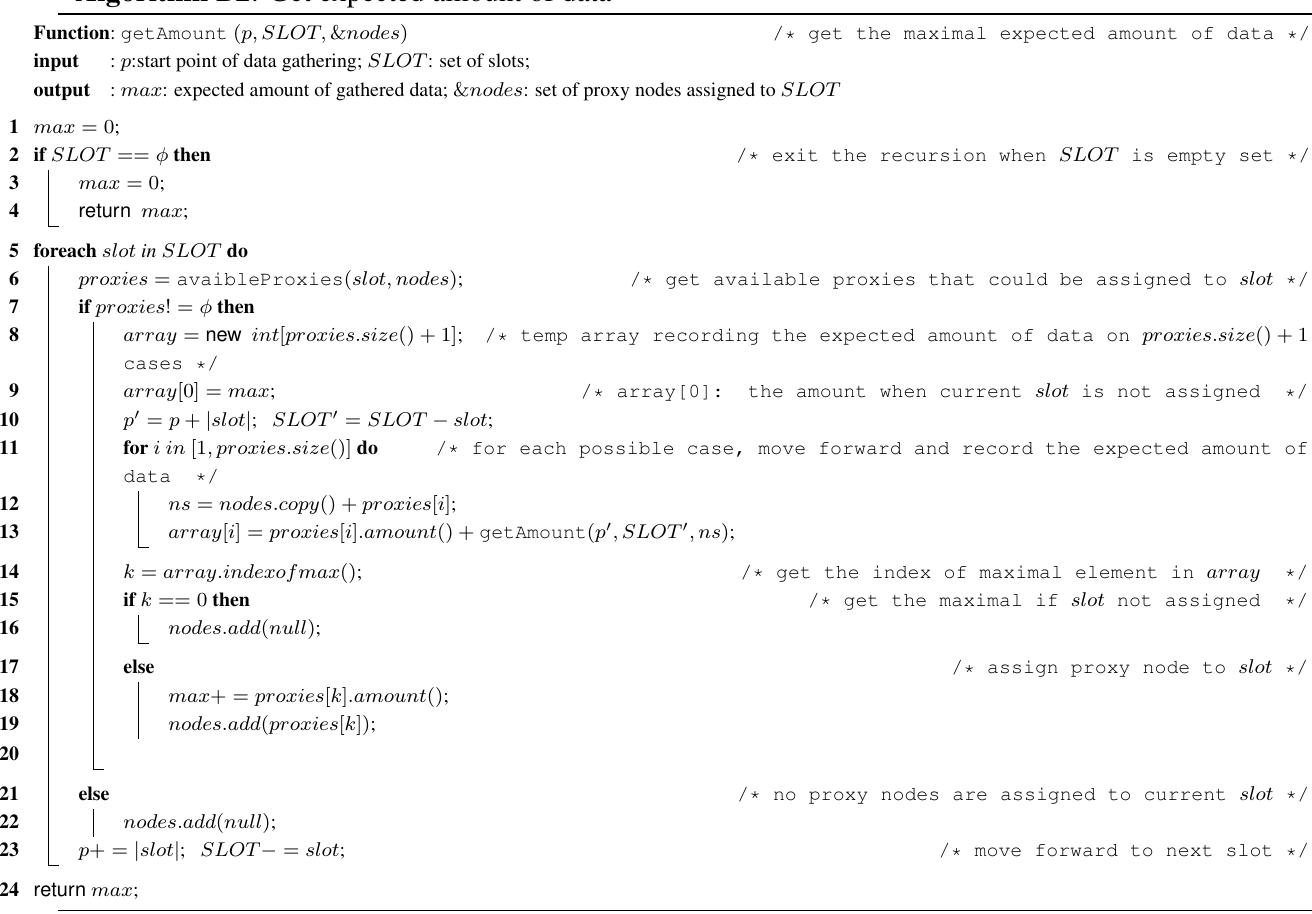
Algorithm B2 : Get expected amount of